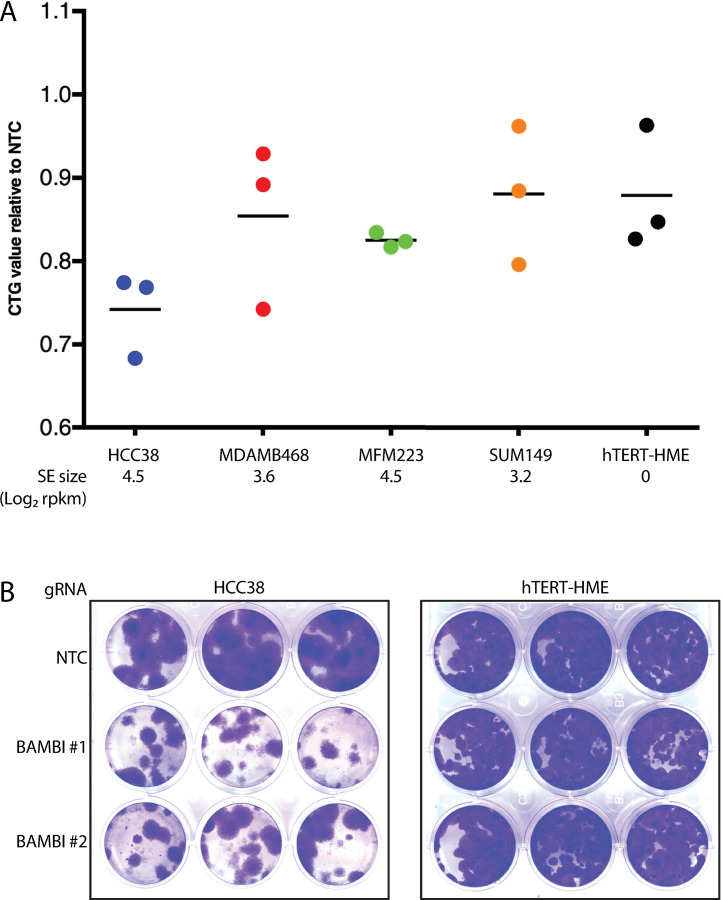
BAMBI dependence is associated with superenhancer acquisition.A) CellTiter-Glo® measurement of cell viability 4 days after BAMBI gRNA transfection. Each point corresponds to a different BAMBI targeted gRNAs, line indicates the mean. BAMBI SE size is indicated below each cell line. B) Colony formation assays 10 days after BAMBI gRNA transfection for the indicated cell lines.